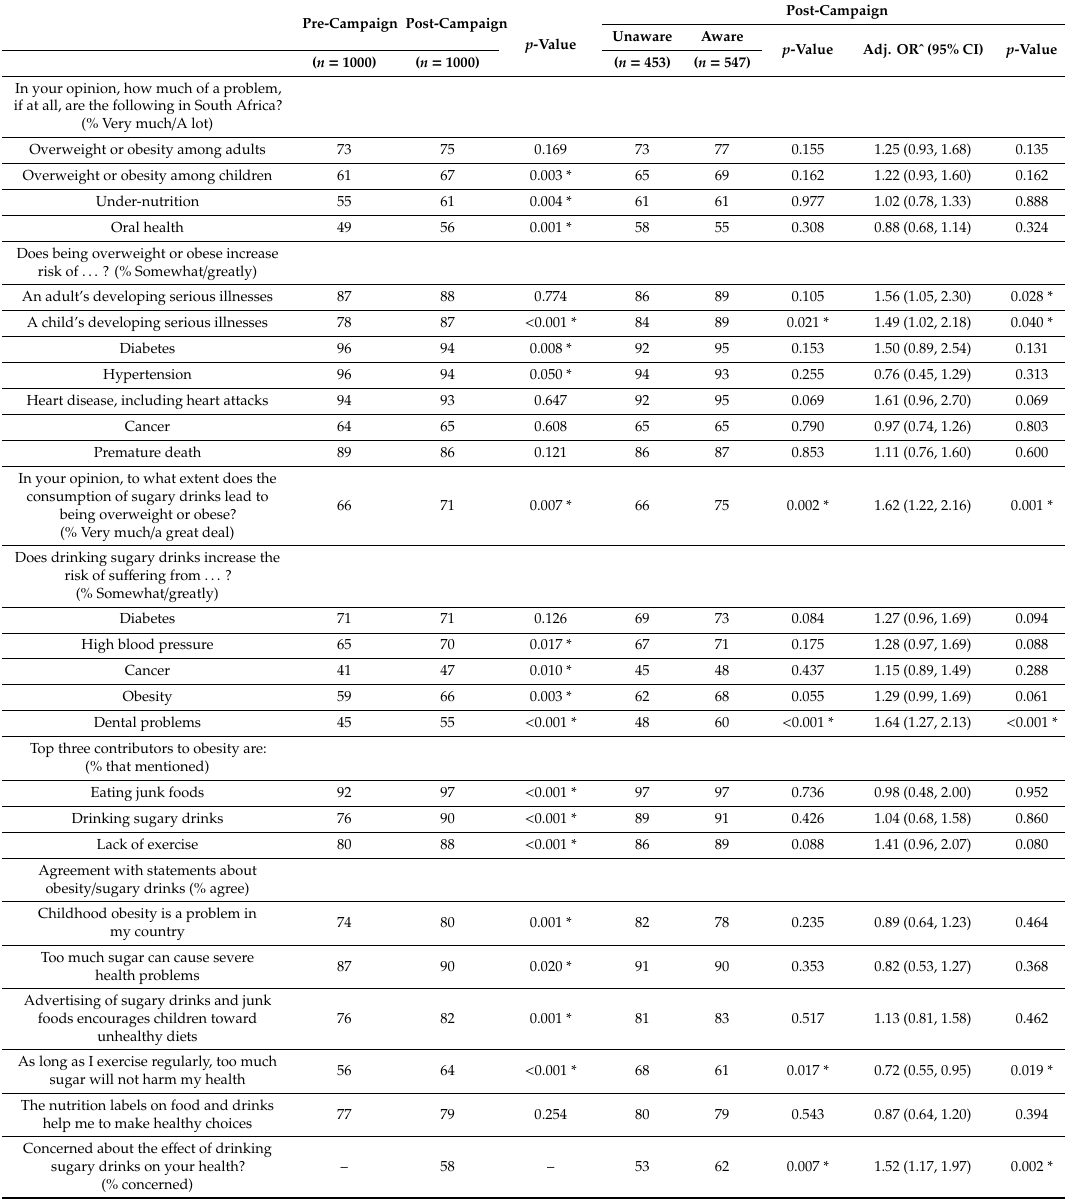
Table 4. Knowledge and attitudes toward obesity and sugary drinks among respondents in the pre-campaign and post-campaign periods, including a comparison of post-campaign respondents who were aware and unaware of the